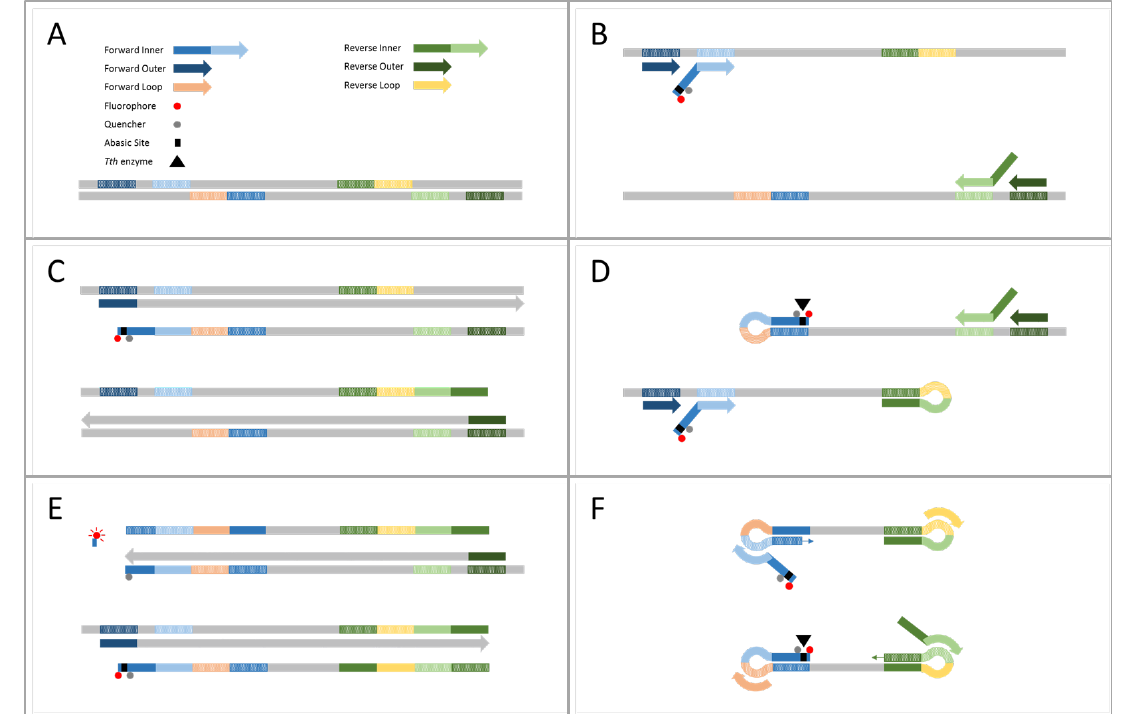
Figure 1. TEC-LAMP mechanism. ( A ) TEC-LAMP oligonucleotide components, Tth endonuclease IV enzyme and dsDNA template with oligonucleotide targets highlighted. ( B ) Temperature enabled dsDNA dissociation followed by primer and TEC primer/probe hybridization to corresponding targets. ( C ) Inner primer strand displacement extension, via Bst polymerase, forms dsDNA. Outer primer